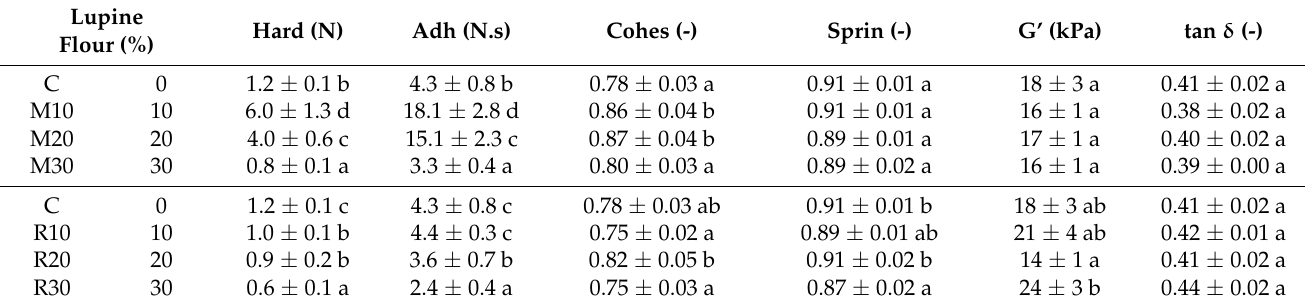
Table 2. Rheological parameters of lupine wheat flour